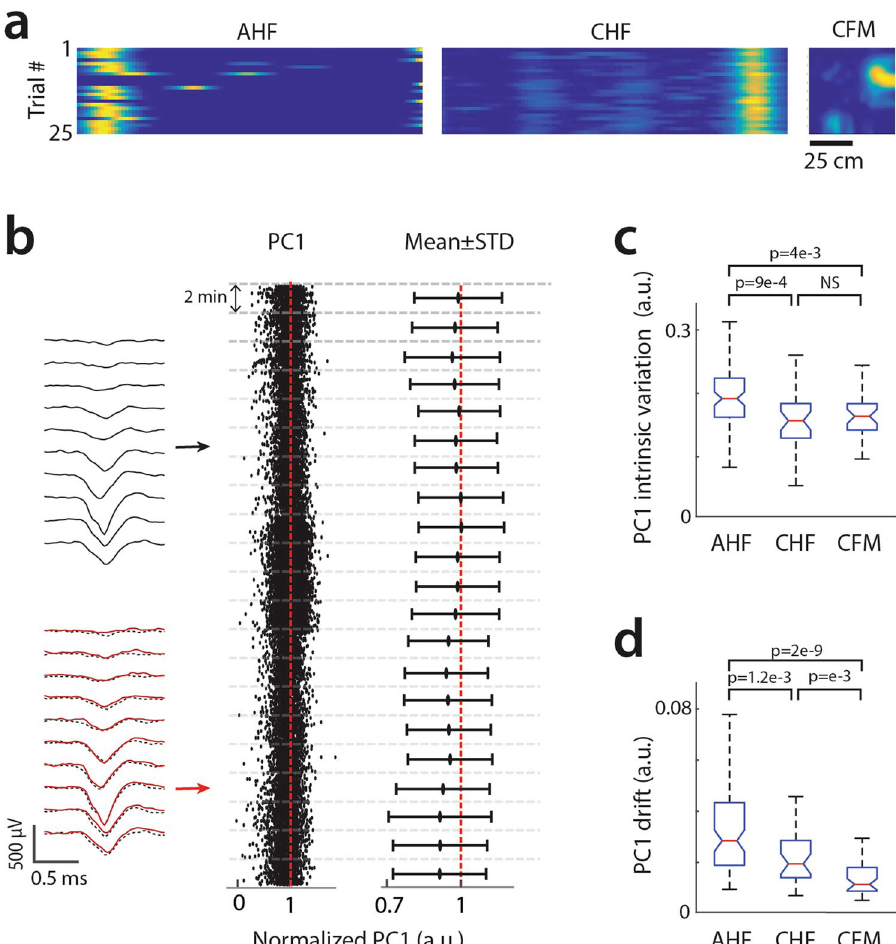
Figure 5. Stability of units for three different recording settings. ( a ) Examples of place cell activity in acute (left, AHF), chronic head-fixed (middle, CHF) and chronic freely moving (right, CFM) settings. ( b ) Temporal evolution of spike waveforms for one cell example. Left, average spike waveforms for 2 ′ time windows early (black) and late (red) in the recording session. The two waveforms are overlaid (red line and black dash line) to facilitate comparison. Middle, first principal components (PC1) of individual spikes. Right, means ± standard deviations of PC1 for consecutive 2 ′ windows. PC1 values are normalized by the maximum of the means. ( c ) Population median (red), quartiles (blue) and edges (black) for cells’ intrinsic PC1 variations for the three recording settings. The intrinsic PC1 variation of each cell was defined as the average over all 2 ′ time windows of the PC1 standard deviations. ( d) Population median (red), quartiles (blue) and edges (black) for cells’ PC1 drifts for the three recording settings. The PC1 drift of individual cells was defined as the average, over all 2 ′ time windows, of the shifts (absolute value) in PC1 mean between consecutive windows. (Kruskal-Wallis test; AHF, n = 83 cells; CHF and CFM, n = 33